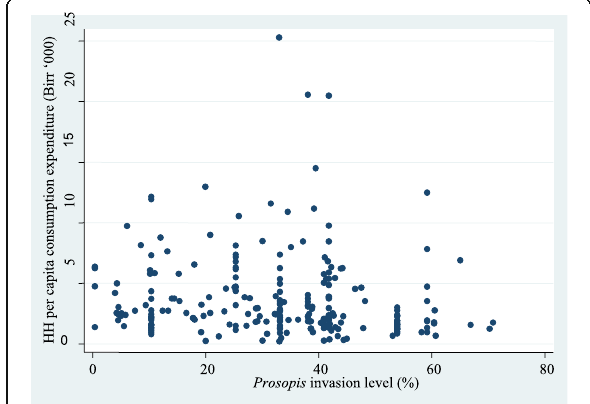
Figure 2 Household per capita expenditure and Prosopis invasion level before an adjustment. HH, household